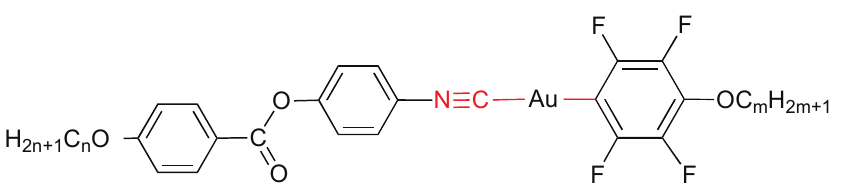
Figure 16. Isocyanide and perfluoroaryl gold mesogens. m = 4, 8; n = 4, 6, 8,